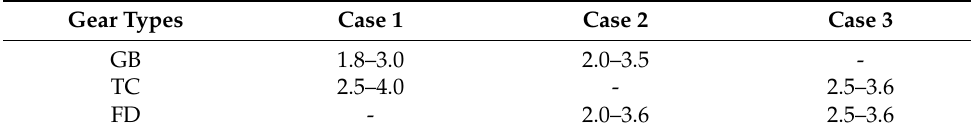
Table 2. Lower and upper ranges of